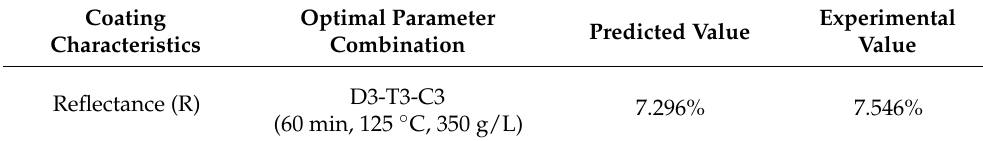
Table 6. Validation of developed mathematical model.